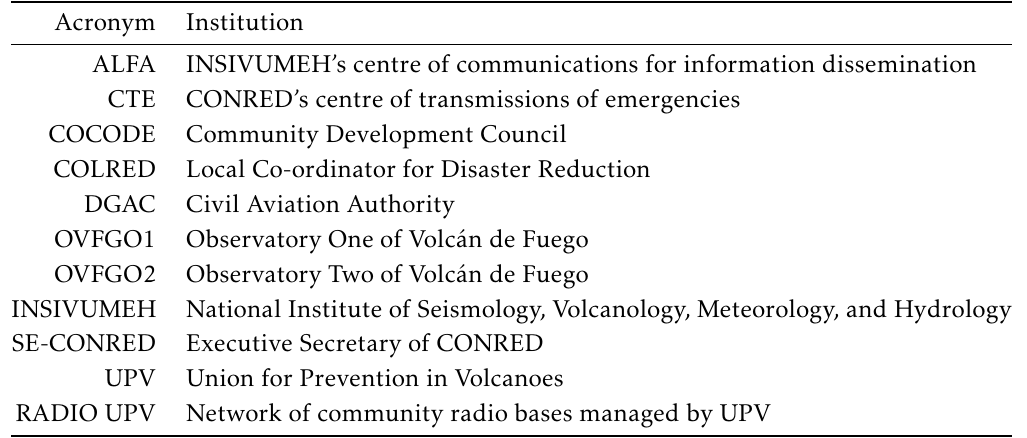
Table 1 – List of acronyms used in this text. All acronyms relate to institutions involved in managing volcanic risk at